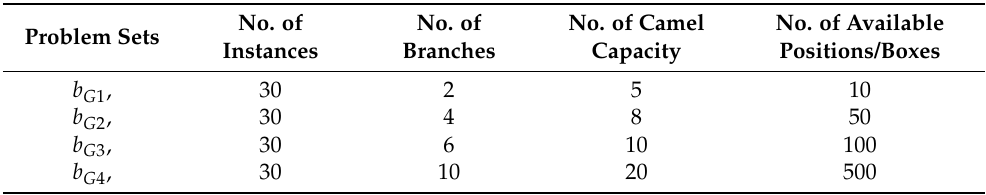
Table 1. Instances the sizes generated